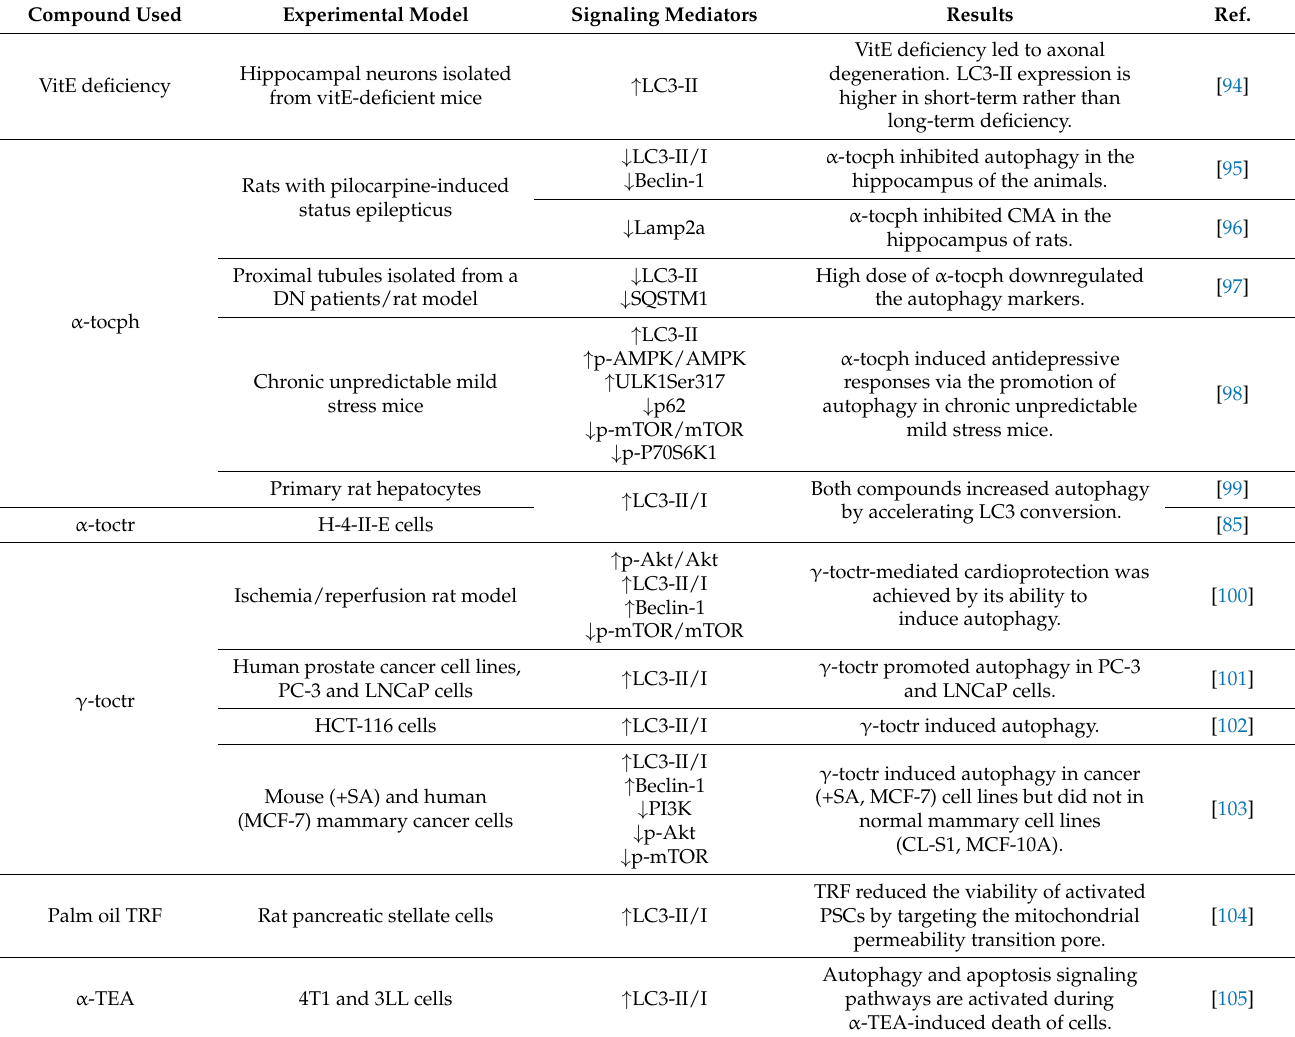
Table 4. Summary of selected available reports on the modulation of autophagy by vitamin E and its